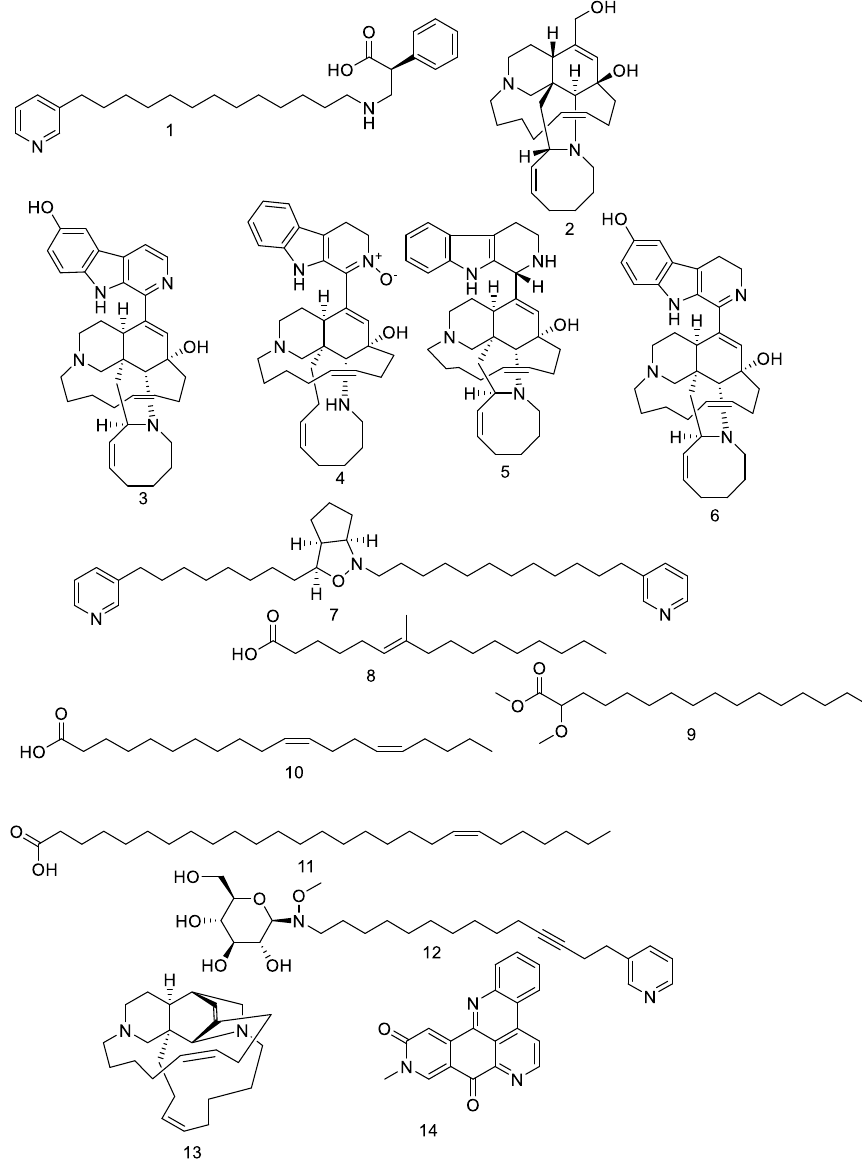
Figure 1. Structures of compounds 1 – 14 .